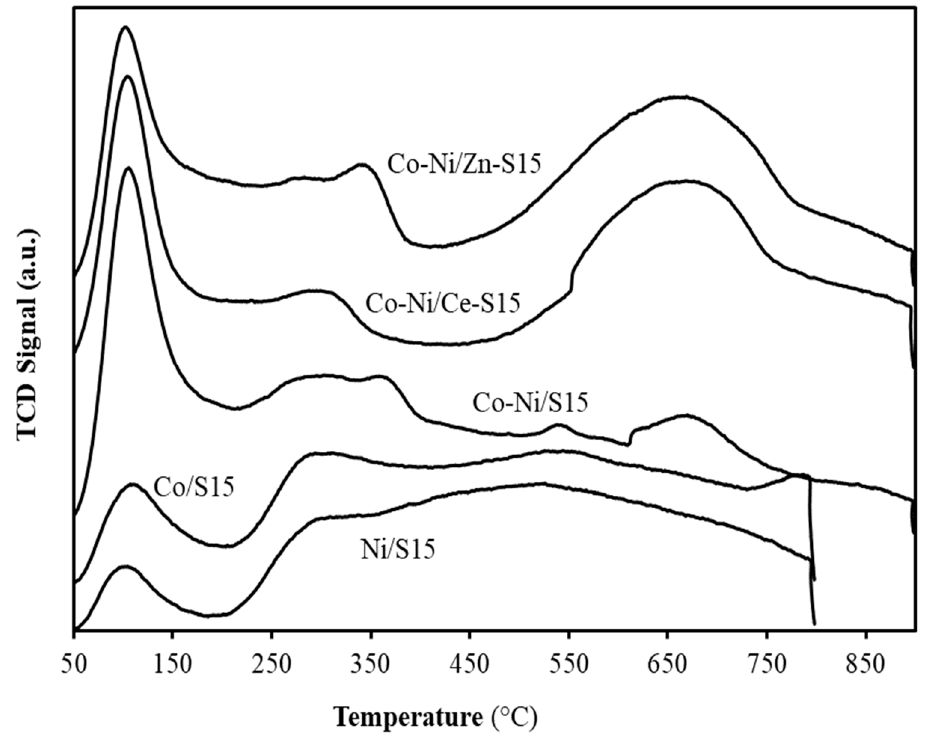
Figure 2. NH 3 temperature-programmed desorption profiles of catalysts.